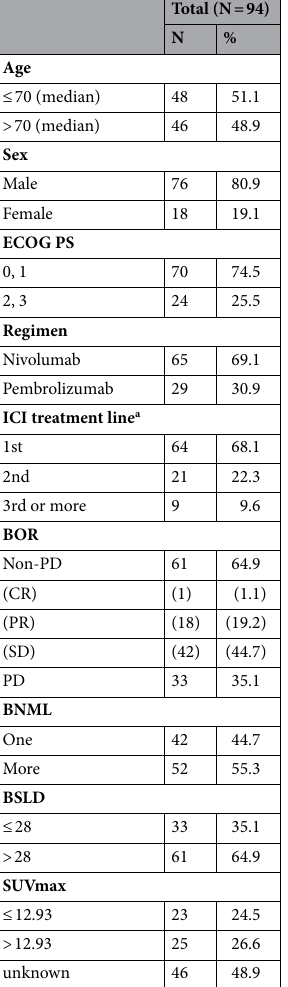
Table 1. Patient characteristics. ECOG Eastern Cooperative Oncology Group, PS performance status, ICI immune checkpoint inhibitor, BOR best overall response, PD progressive disease, BNML baseline number of metastatic lesions, BSLD baseline sum of target lesions’ longest diameters, SUV standardized uptake value. a ICI treatment line was counted as the number of systemic chemotherapy for recurrent or metastatic head and neck